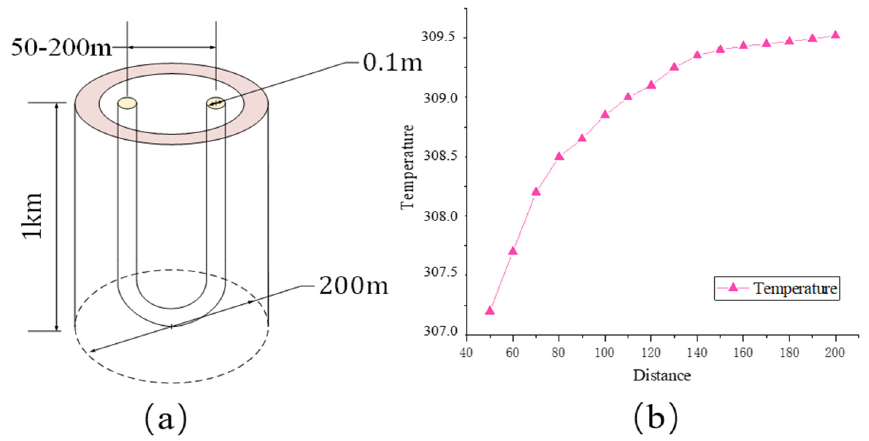
Figure 6. ( a ) Different well distance; ( b ) change in production temperature at different well distances.